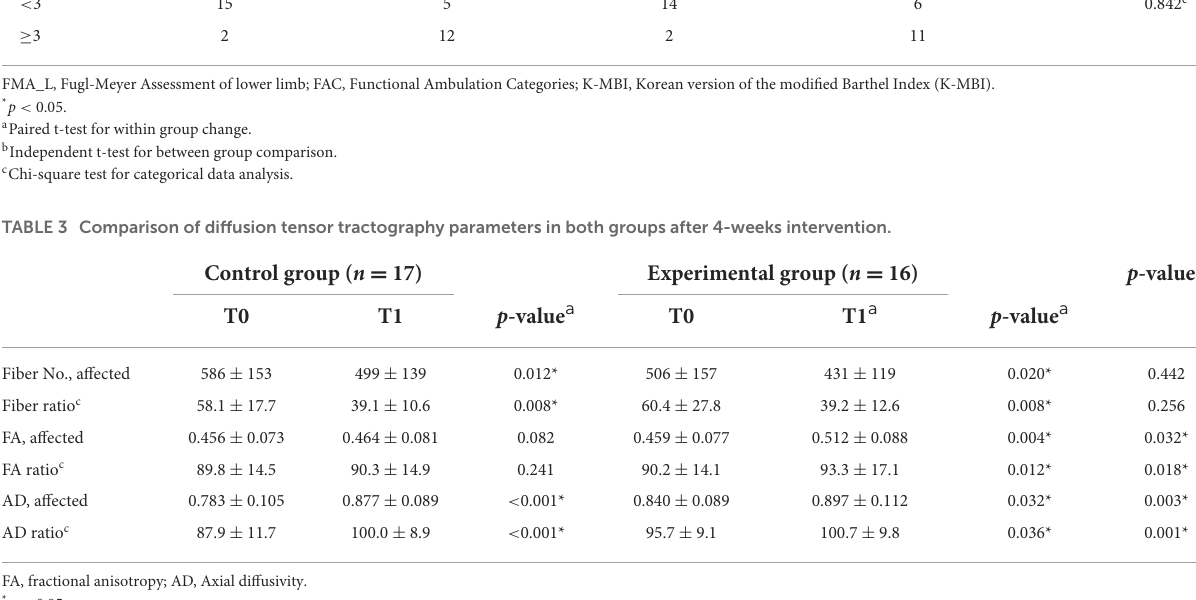
9.8 ( p = 0.036) in the experimental group after treatment.